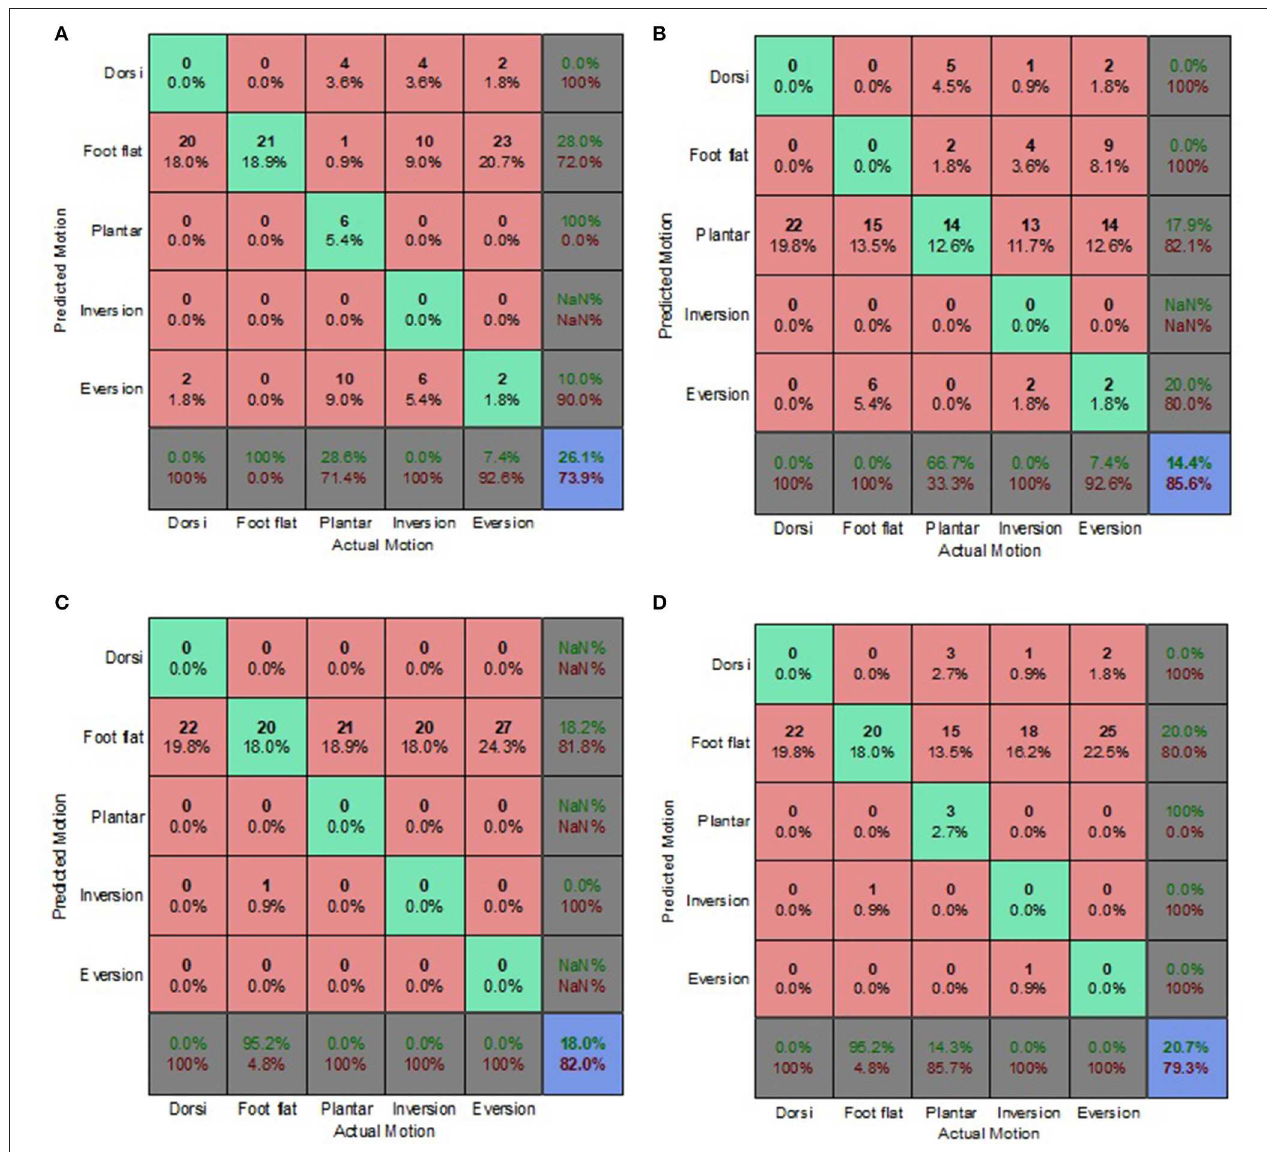
FIGURE 11 | Electrode Shift Condition Decoupled Data Set—LG Walking Style Approach. (A) Tree, (B) LDA, (C) Deterministic, and (D) Voting